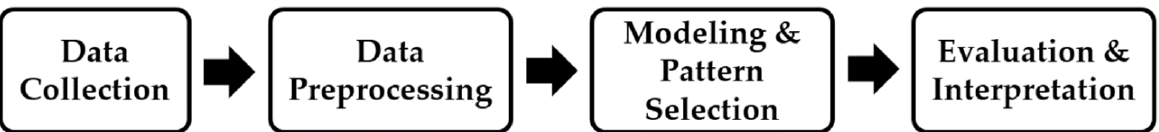
Figure 1. Methodology of the proposed soil moisture forecasting model .